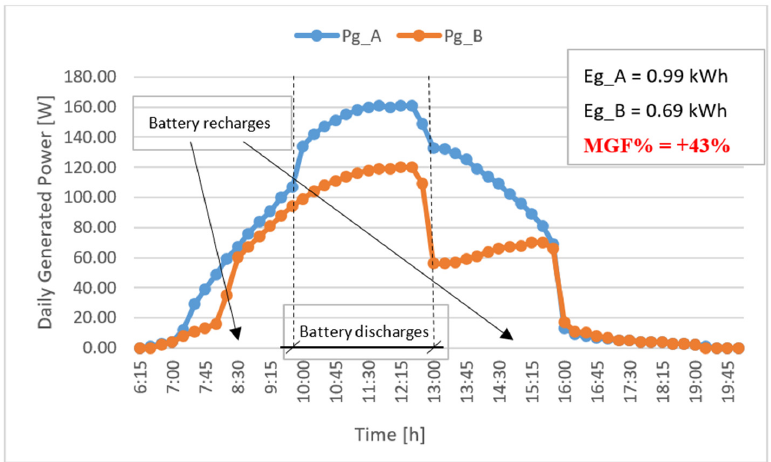
Figure 14. Daily power generation curves, Pg_A and Pg_B, of the two prototypal PV generators A and B on an August 2021 cloudless day, together with the corresponding daily generated energy values, Eg_A and Eg_B, and the percentage major generation factor, MGF%. In this experiment, two identical shading plywood sheets were mounted on three PV cells of both homemade submodules of the PV generator A and B. On the submodule of the PV generator A, the battery control unit was activated while the bypass diode of the submodule of the PV generator B intervened early, but it left the conduction mode at about 13:00.